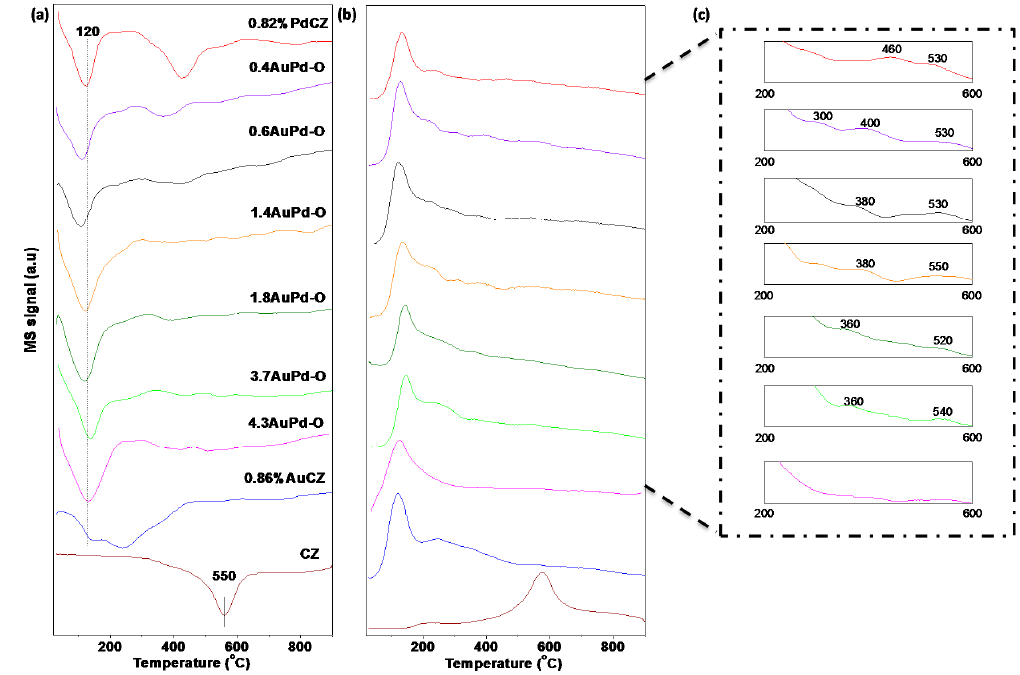
Figure 5. Temperature programmed reduction (TPR) profiles of the monometallic and bimetallic catalysts and support: ( a ) consumption of hydrogen; ( b ) formation of H 2 O; ( c ) the enlarged H 2 O formation profiles between 200 °C and 600 °C.